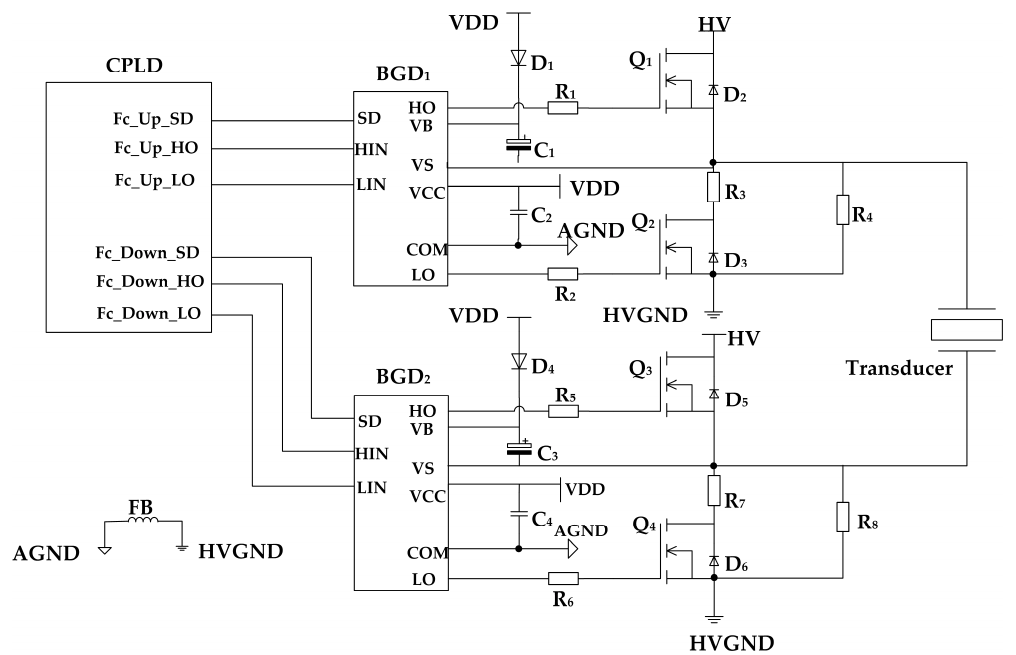
Figure 7. Schematic diagram of the acoustic emission circuit.